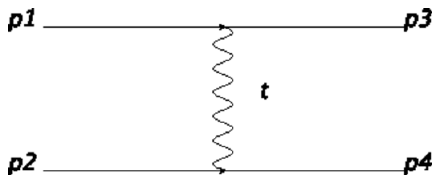
Figure 2 . t-graviton exchanged between two